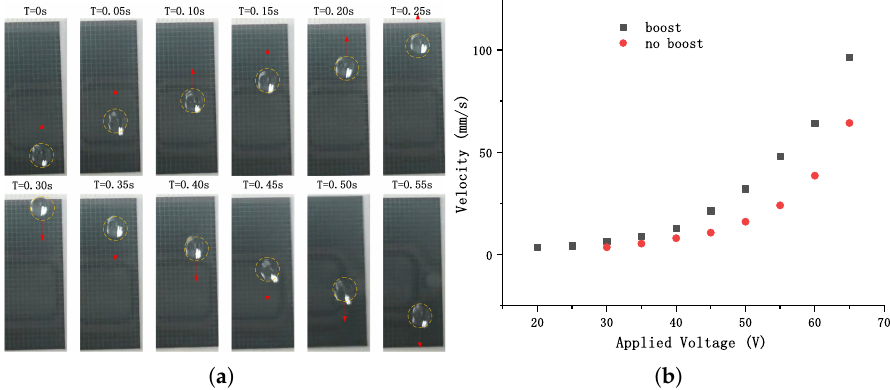
Figure 11. ( a ) Video screenshots (from 0 to 0.55 s) of velocity test of the droplet on the device with in-pixel boost circuit. ( b ) Experiment results of the droplet velocity with different applied voltage on the device with (black)/without (red) in-pixel boost